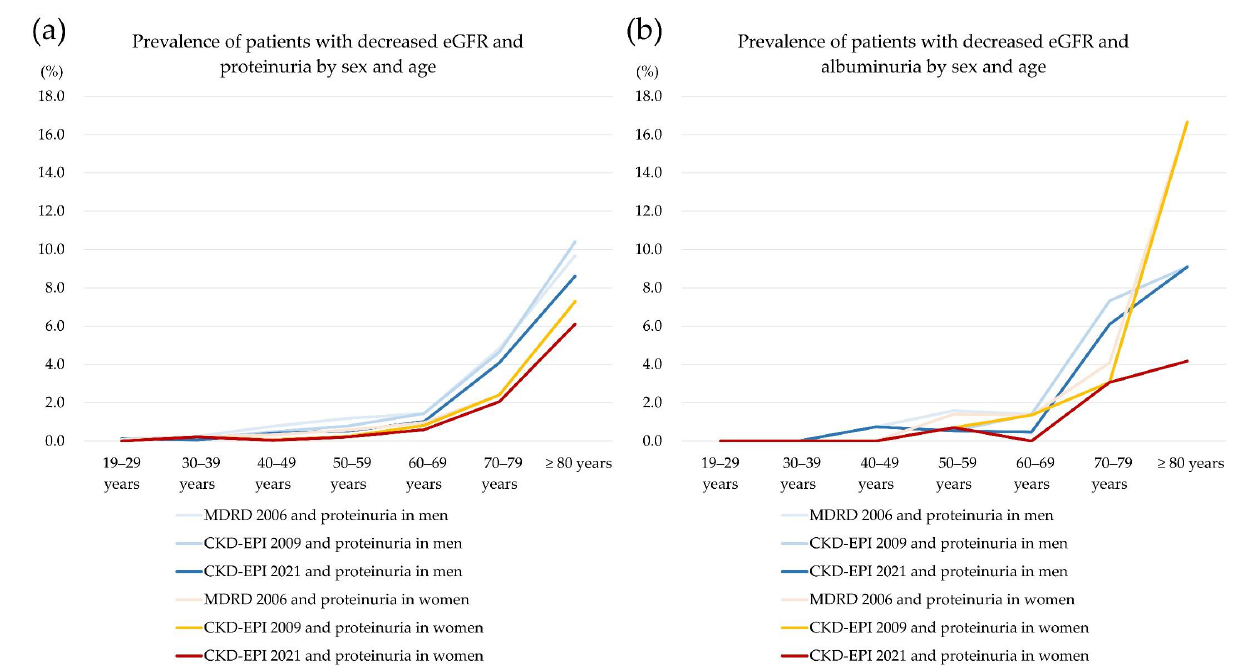
Figure 4. Prevalence of specimens with decreased eGFR (<60 mL/min/1.73 m 2 ) and proteinuria ( ≥ 1+ in a dipstick urine protein test) or albuminuria (ACR > 30 mg/g creatinine) by sex and age.